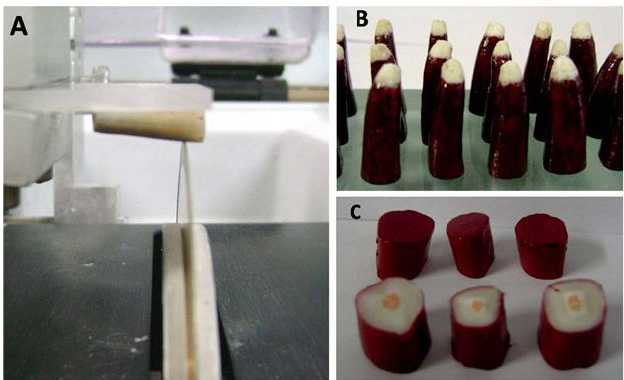
Fig. 1- A . Root cross-section, B. Nail polish coating to apical leakage (groups A1 and B1), and C. Nail polish coating to the middle canal third leakage (groups A2 and